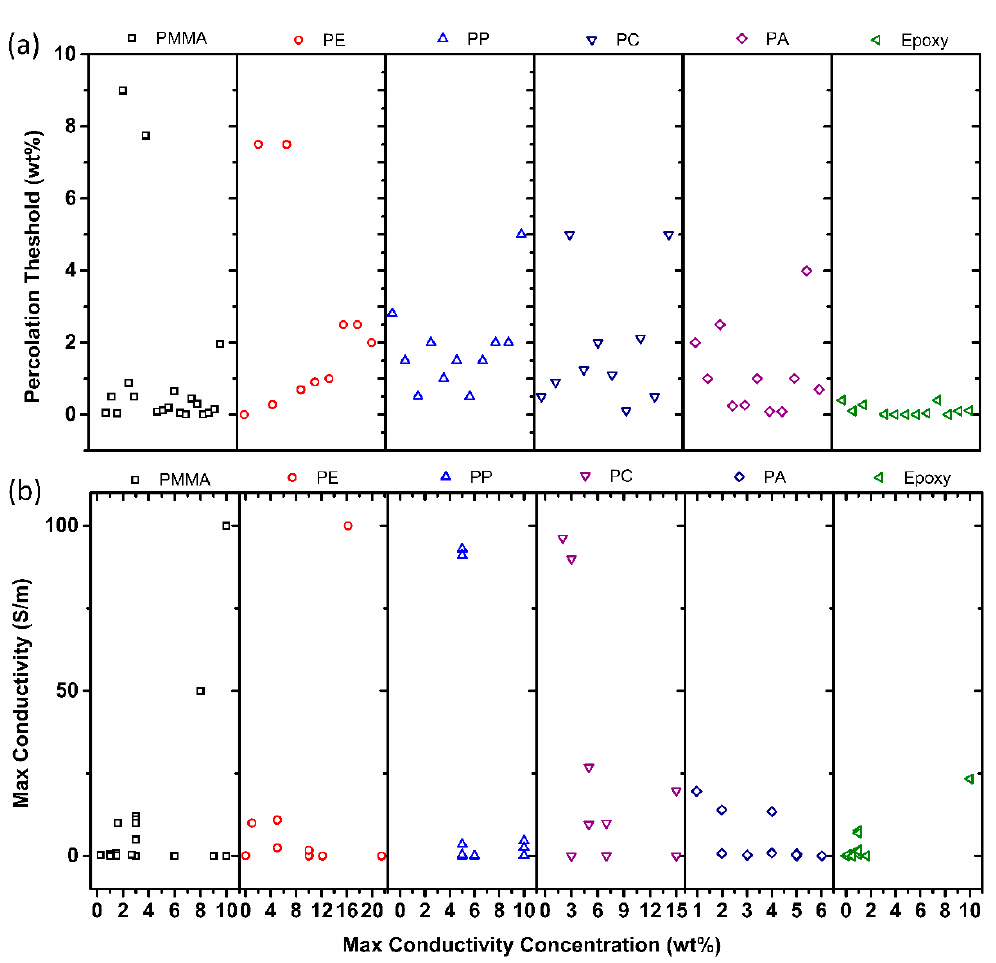
Figure 4. ( a ) Percolation threshold and ( b ) max conductivity values at various MWCNT contents for